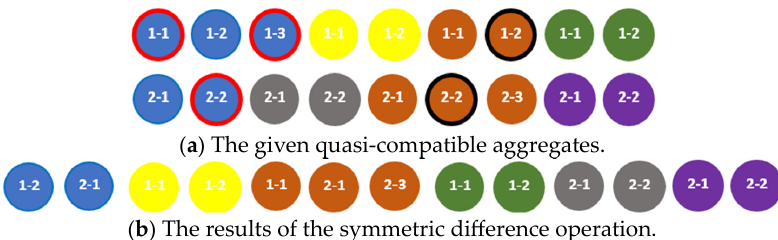
Figure 13. An example of applying the symmetric difference operation to two compatible aggregates.